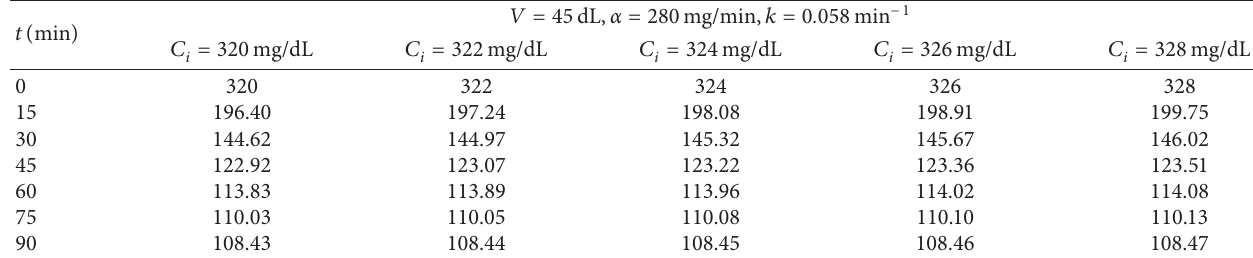
t with i and time